Question: Give a one-sentence summary of this figure.
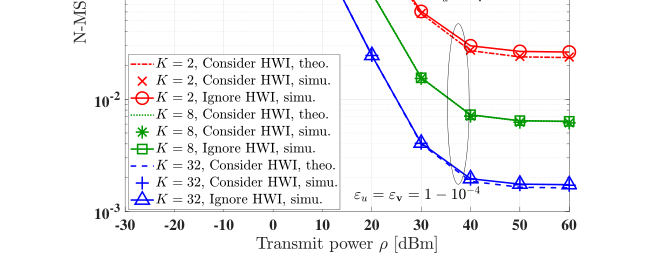
Answer: Comparison of the N-MSE versus the transmit power.